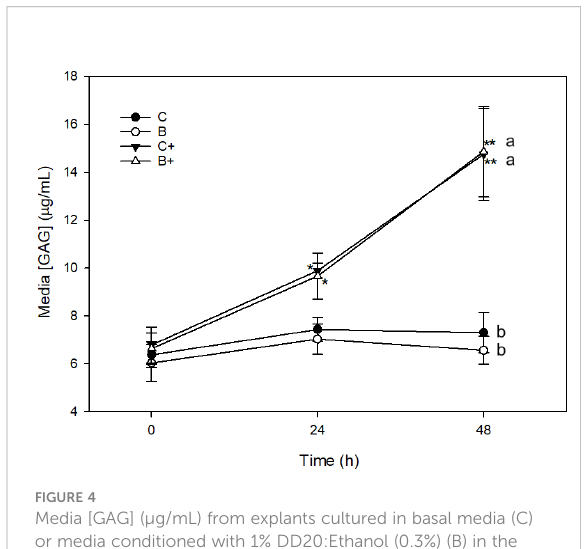
FIGURE 4 Media [GAG] (µg/mL) from explants cultured in basal media (C) or media conditioned with 1% DD20:Ethanol (0.3%) (B) in the presence (+) or absence of lipopolysaccharide (10 µg/mL). *denotes signi fi cant change from baseline within treatments. Letters denote signi fi cant difference between treatments at individuals time